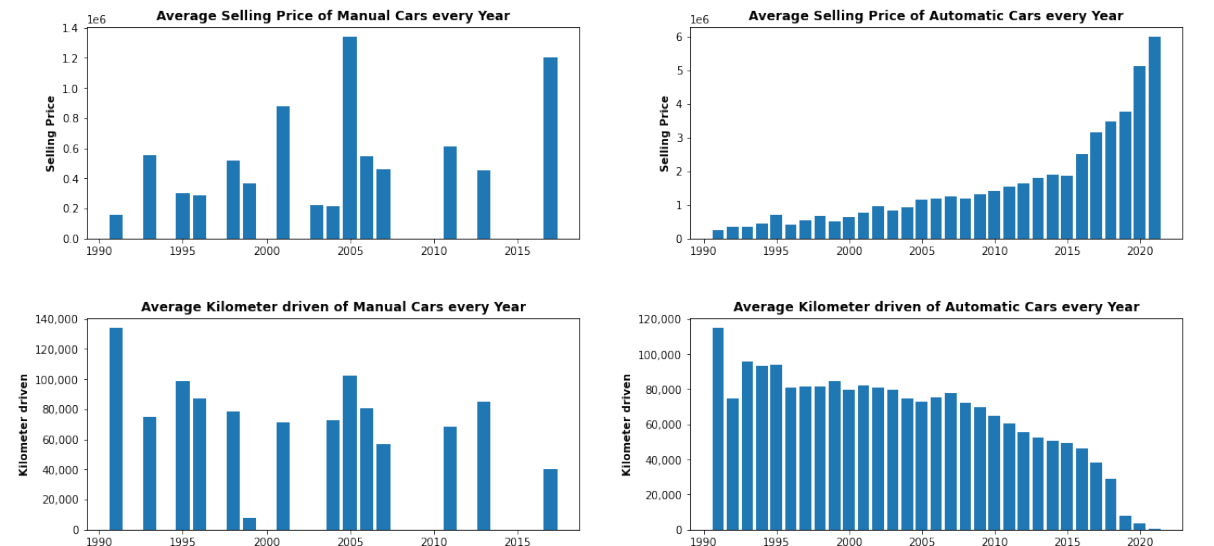
Figure 15. Average selling price and average kilometers_run for automatic and manual